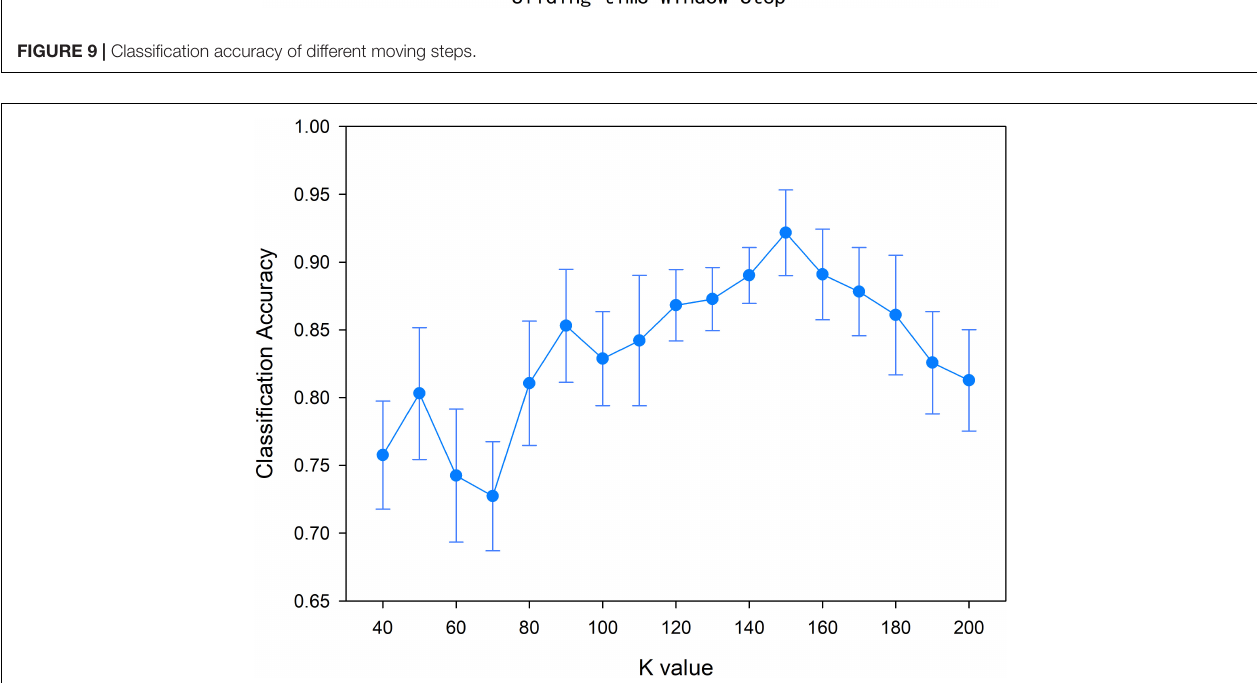
FIGURE 10 | Classification accuracy of different k values based on the high-order functional hypernetwork.